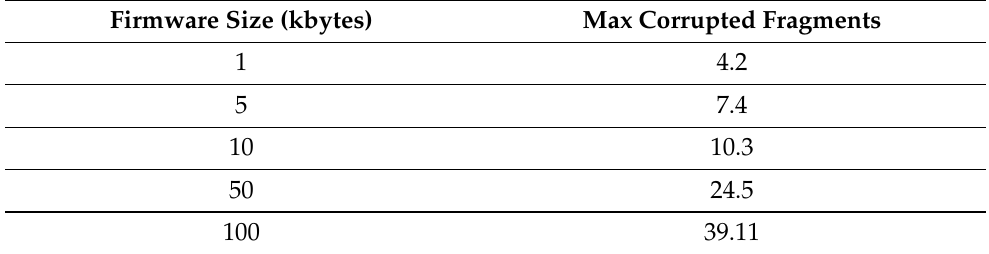
Table 2. Max corrupted fragments using multiple firmware sizes.